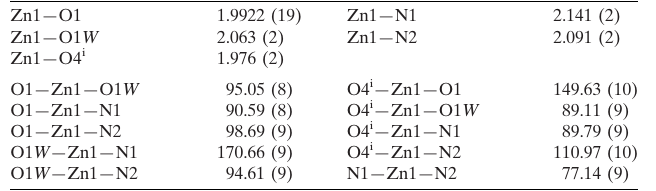
Selected geometric parameters (A˚ , (cid:3) ).